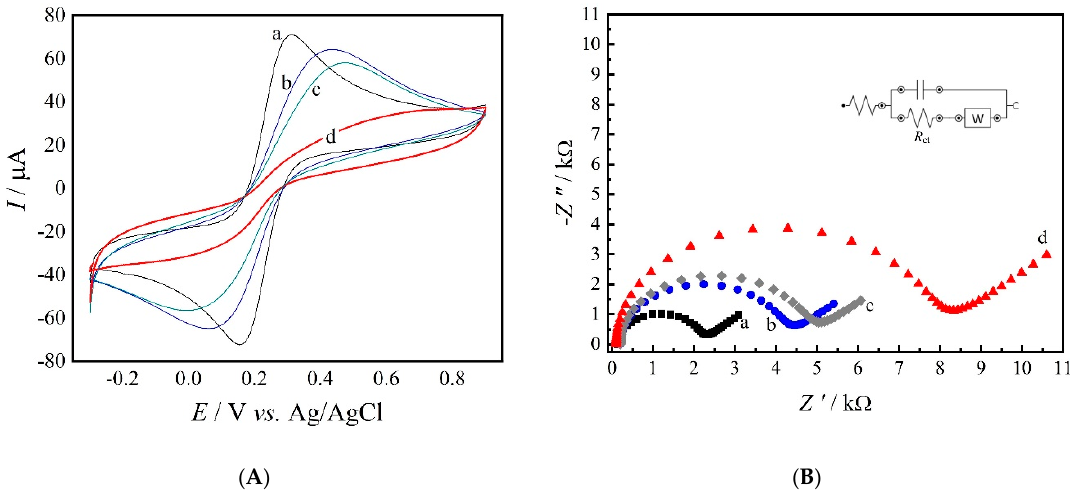
Figure 4. Cyclic voltammograms ( A ) and Nyquist plots ( B ) for: (a) GC / rGO, (b) GC / rGO / anti-SEA, (c) GC / rGO / anti-SEA / BSA and (d) GC / rGO / anti-SEA / BSA / SEA. Both experiments were performed in a 0.2 mol L − 1 PBS (pH 7.4) solution containing 0.1 mol L − 1 of KCl and 5.0 mmol L − 1 of Fe(CN) 6 ] 3 − / 4 − . Inset : equivalent circuit.